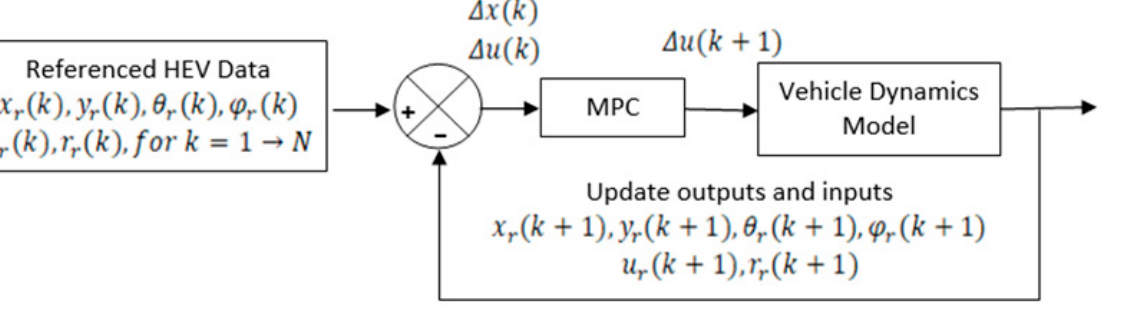
Figure 3. Diagram of the MPC system.